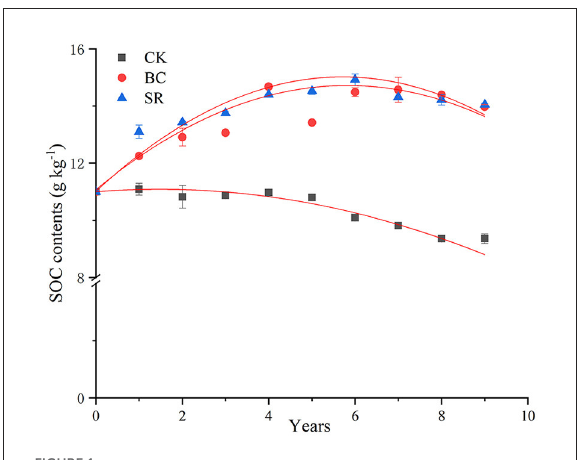
FIGURE1 Dynamics of SOC contents during straw and biochar application for 9 consecutive years. The data of the first 3 years was cited from Yang et al. (2017a). Bars represent standard deviations ( n =